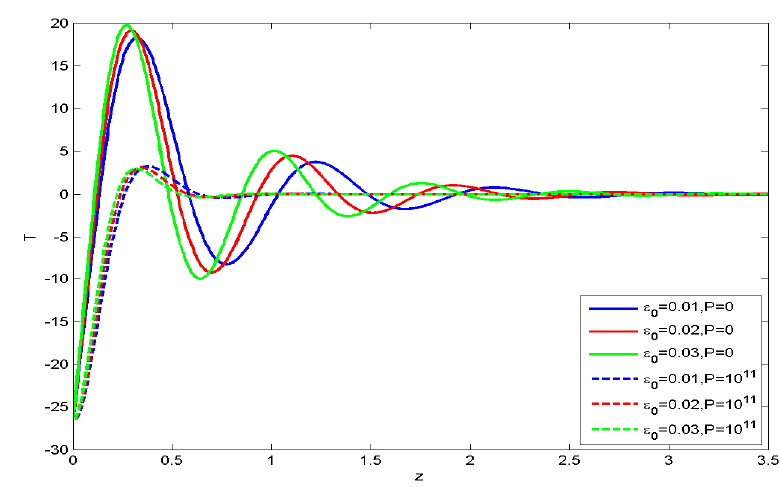
Figure 17. Temperature T concerning z with electric field ε 0 .